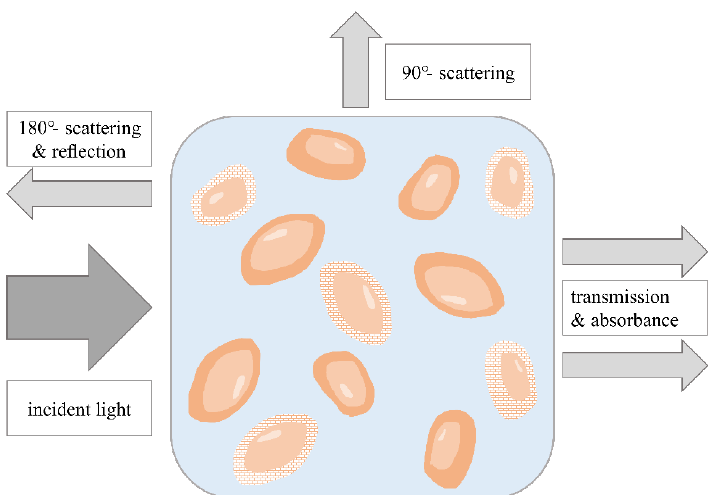
Figure 2. Monitoring of cell viability using different UV-vis spectroscopic methods. Different physical effects can be used for analyzing turbid cell suspensions depending on the arrangement of the light source and the detector. Based on [2].